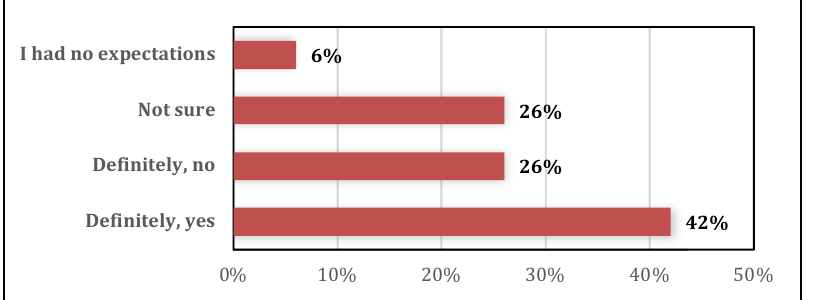
Fig. 7. Students’ expectations on